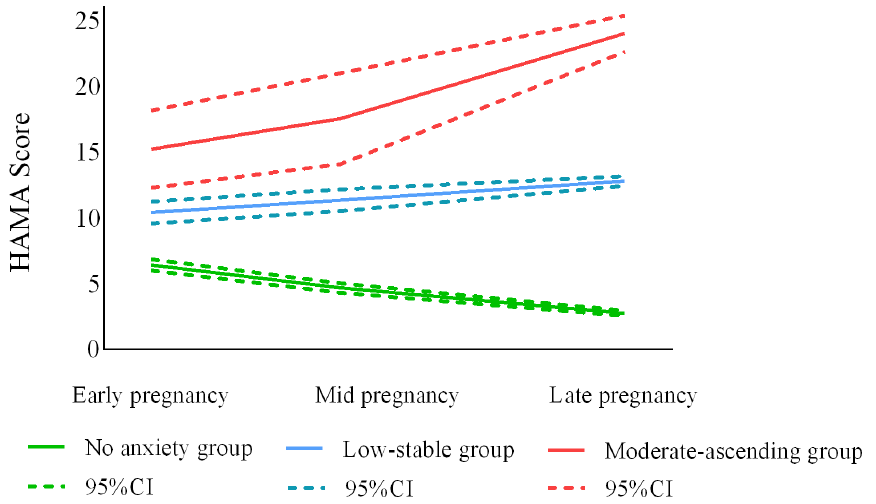
Figure 2. Optimal model trajectory curves for prenatal anxiety (n = 916).